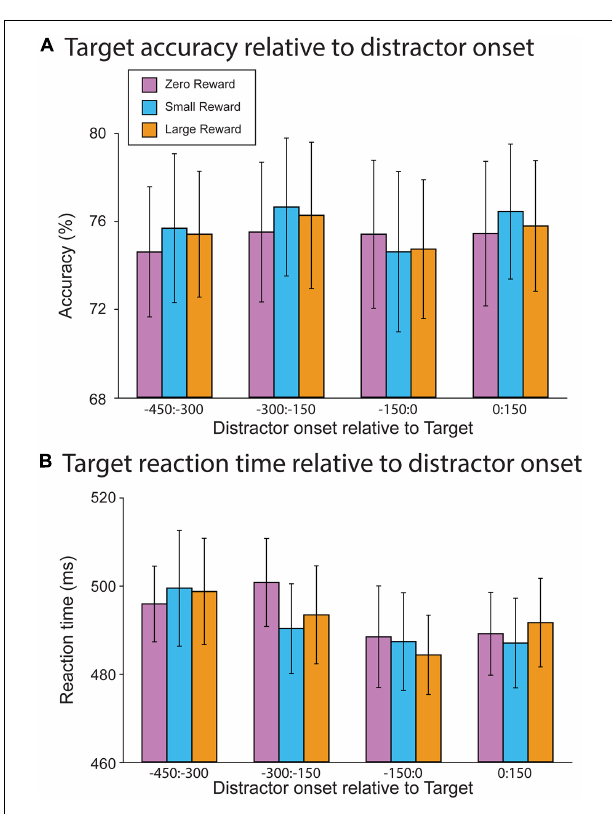
FIGURE 3 | Behavioral results from the RSVP task. (A) Target accuracy as a function of relative distractor onset time. Distractors did not impact target accuracy as a function of either onset time or reward magnitude. (B) Target reaction time as a function of distractor onset time. There was a trend toward faster reaction times when the distractor occurred just prior to target onset. However, this did not differ as a function of reward